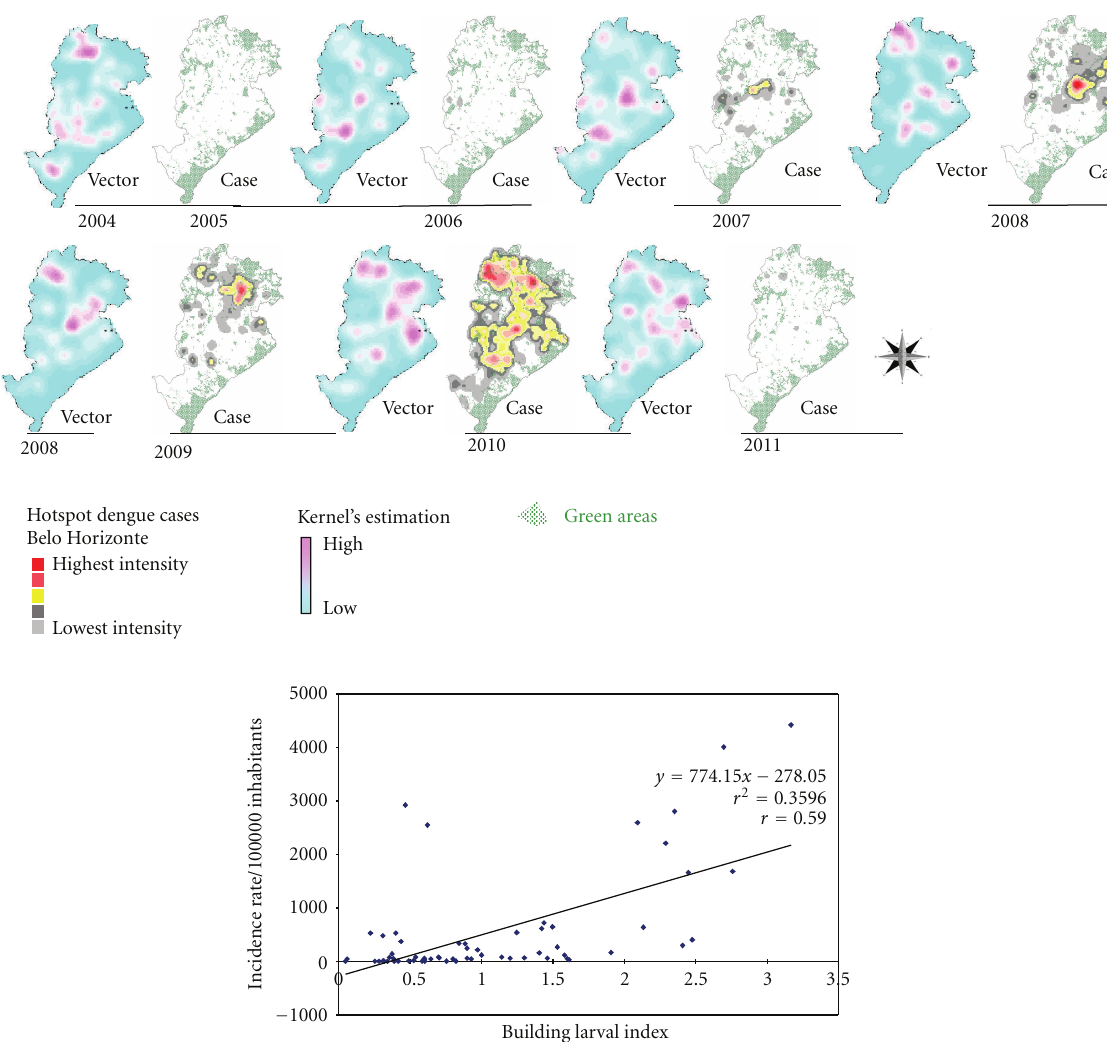
Figure 5: Temporal dynamics in space, foci of Aedes aegypti larvae Kernel’s estimation in October survey and dengue hotspot outbreaks, 2004–2011, and regression linear graphic (incidence versus building larvae index), Belo Horizonte/MG, Brazil.